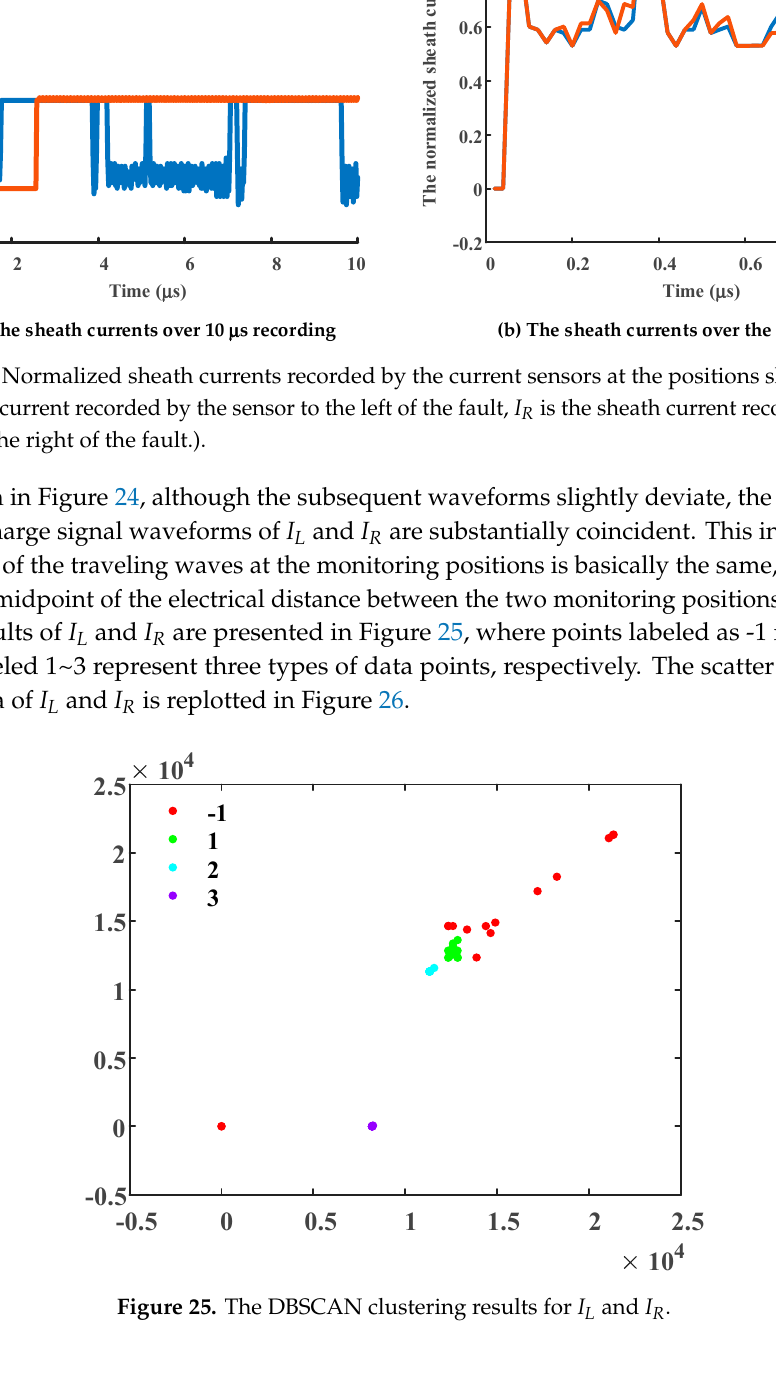
Current sensor Figure 23. The on-site photos of the test MV (medium voltage) cable circuit. The test was carried out on a sunny winter day (24 January 2019). First, the manually constructed defective joint was connected in the cable and the current sensors were installed in the test circuit, as shown in Figure 23. A series resonant source is used to raise the voltage step-by-step until a breakdown occurs in the defective cable joint. During the process of raising the voltage there were several obvious discharges, visually and/or audibly observed, before the penetrating breakdown occurs. As the data sampling rate is high (50 MHz), the sampling time cannot be too long (dozens of microseconds). Normally, the first recorded data is used for fault location. However, as the buffer of